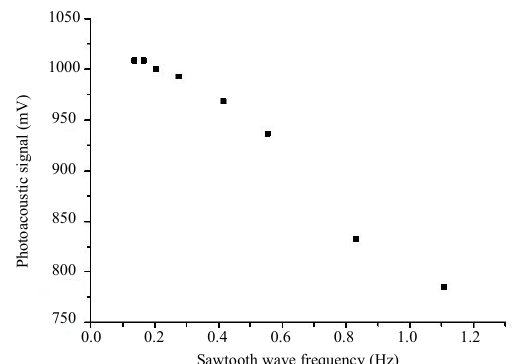
Fig. 4 Photoacoustic signal at different sawtooh wave frequencies.